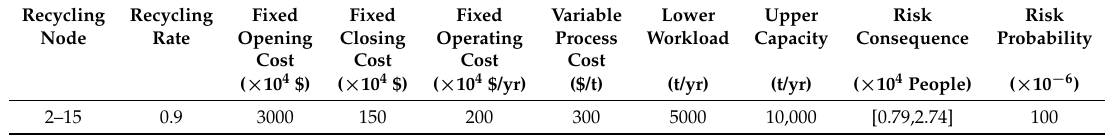
Table 1. Candidate recycling centers.